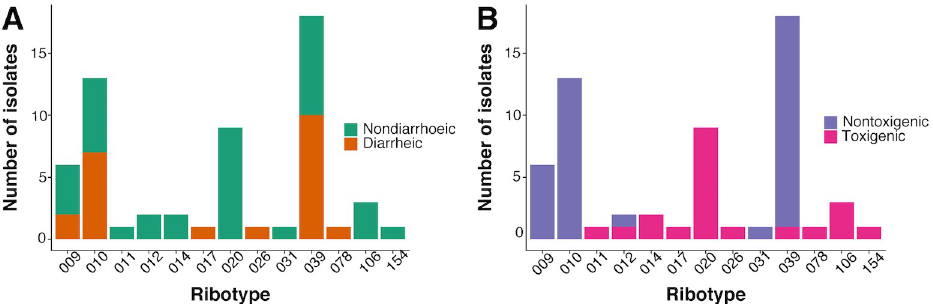
Fig 1. Ribotypes of C . difficile from dogs in this study, shown according to whether they were isolated from dogs with or without diarrhoea (A) and whether strains were classed as toxigenic or nontoxigenic (B) based on a PCR positive test for either or both tcd A and tcd B genes.